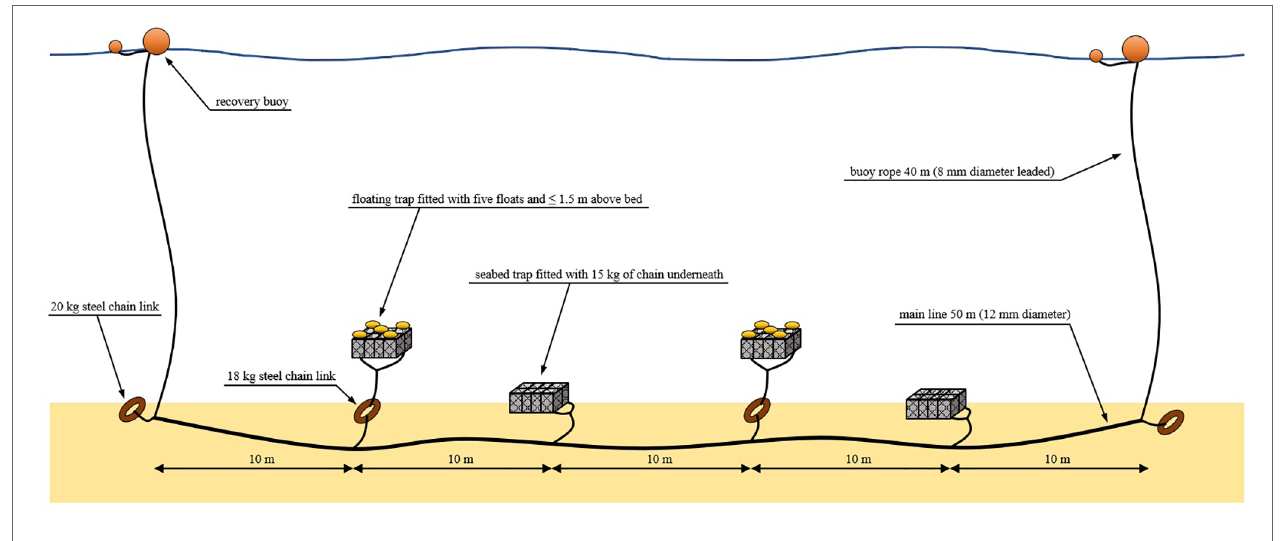
FIGURE 4 | Gear configuration schematic showing rigging of a string of fish traps as deployed during this